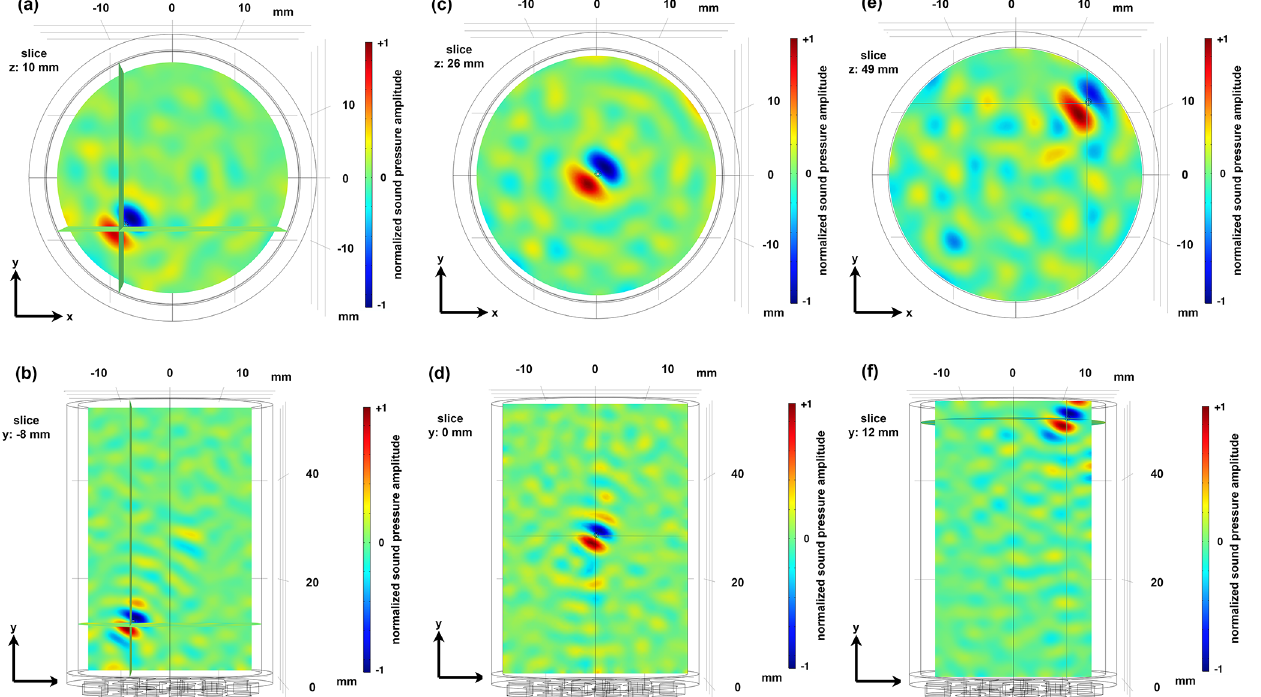
Figure 8. Representation of the sound pressure field in the cavity when generating the bottle trap at three different positions. (a, b) Bottom left near the wall of the cavity and just above the time reversal mirror, (c, d) in the middle of the cavity and (e, f) top right near the water–air transition and near the wall of the